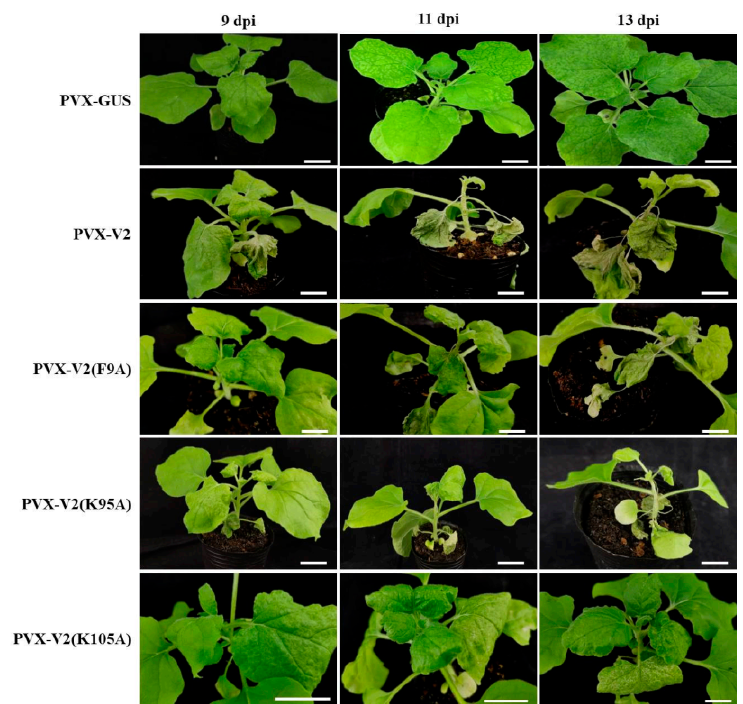
Figure 6. Symptom aggravation induced by V2-expressing PVX is independent of the RNA silencing suppression activity of V2. Symptoms induced by chimeric PVX expressing wt V2 or V2 mutants. PVX expressing partial β -glucuronidase (GUS) gene served as control. PVX-V2, PVX-GUS, PVX- V2(F9A), PVX-V2(K95A) and PVX-V2(K105A) were inoculated into N. benthamiana respectively at the six-leaf stage, and symptom images were taken at 9, 11 and 13 days post inoculation (dpi). Scale bar, 3